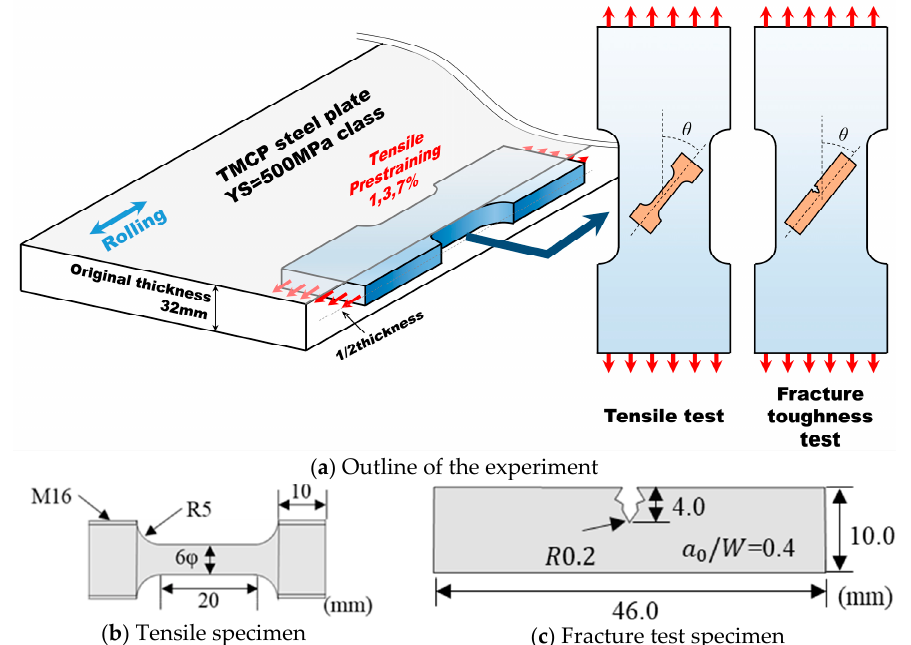
Figure 2. Schematic illustration of the experiment and configuration of the tensile and fracture test specimens. TMCP: thermomechanical control process. ( a ) Outline of the experiment, ( b ) Tensile specimen, ( c ) Fracture test specimen.